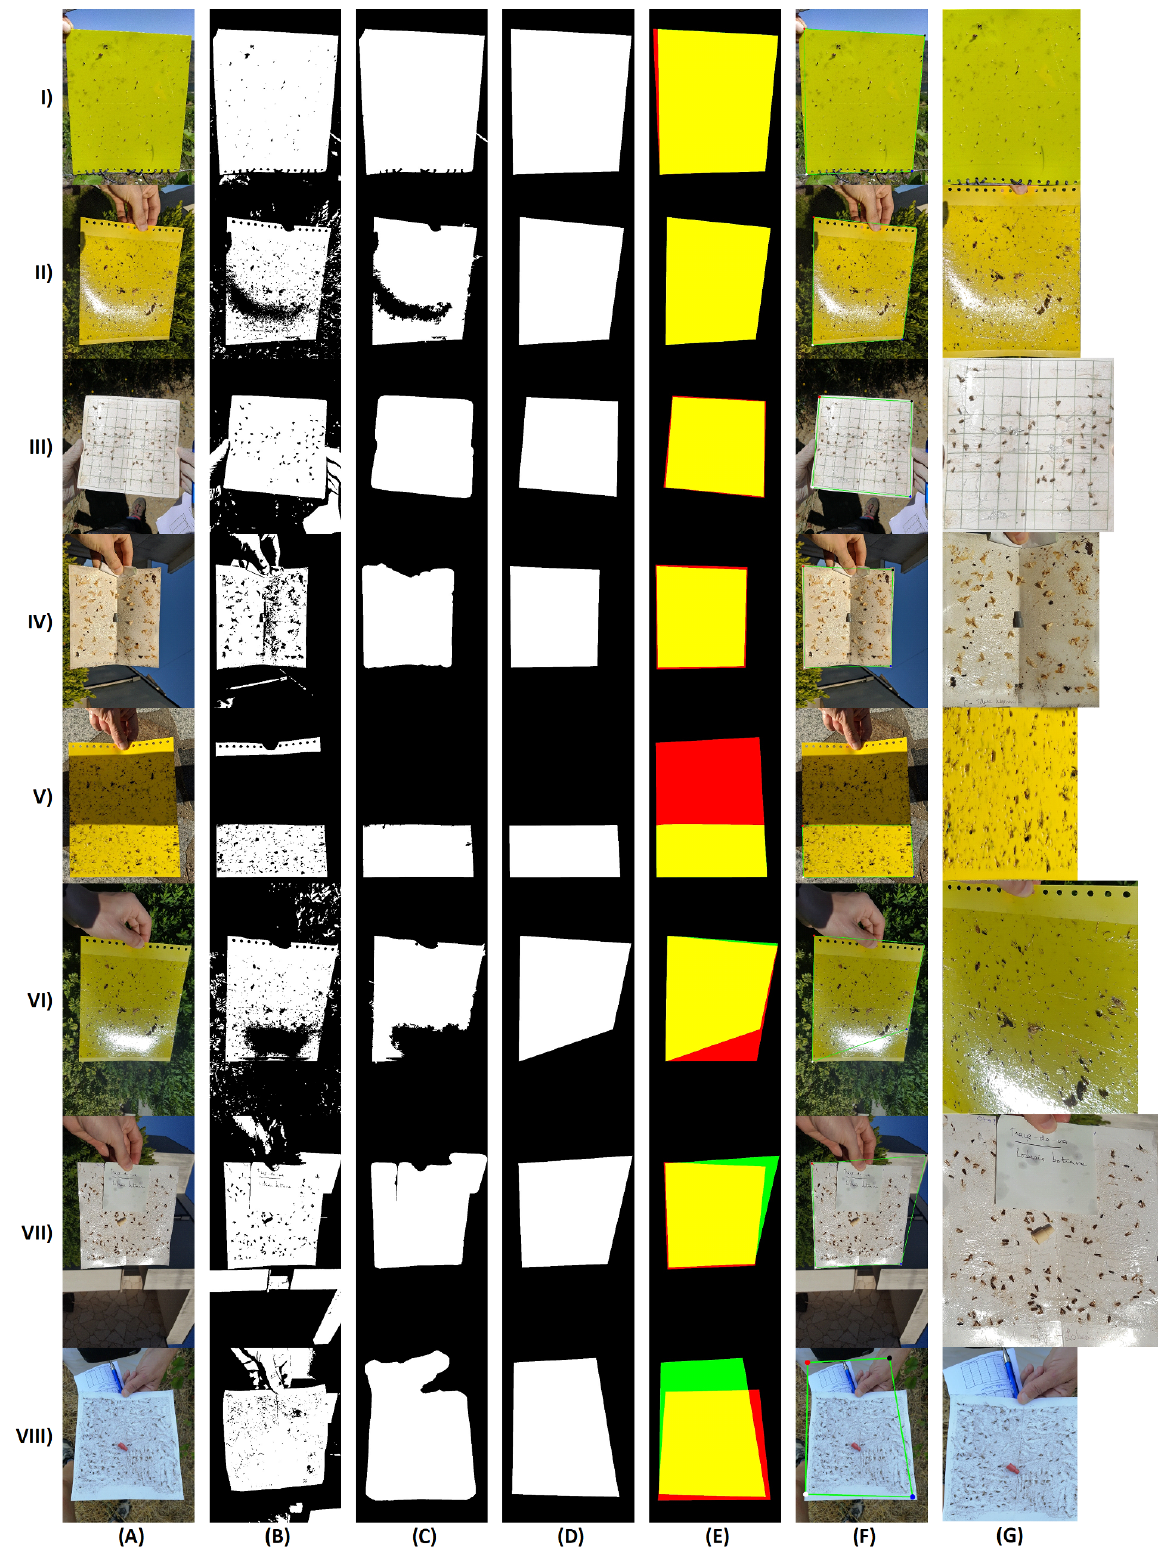
Figure 8. Illustrative images of high JA (I to IV) and low JA (V to VIII) for trap segmentation results: ( A ) original image; ( B ) Otsu’s segmentation; ( C ) post-processing (morphological operations, area filtering and hole-filling); ( D ) segmentation with polygonal approximation; ( E ) comparison image between segmentation and ground truth; ( F ) corner points from polygonal approximation; ( G ). Transformed image with corrected perspective. (In comparison images: yellow—true positives; red—false negatives; green—false positives; black —true